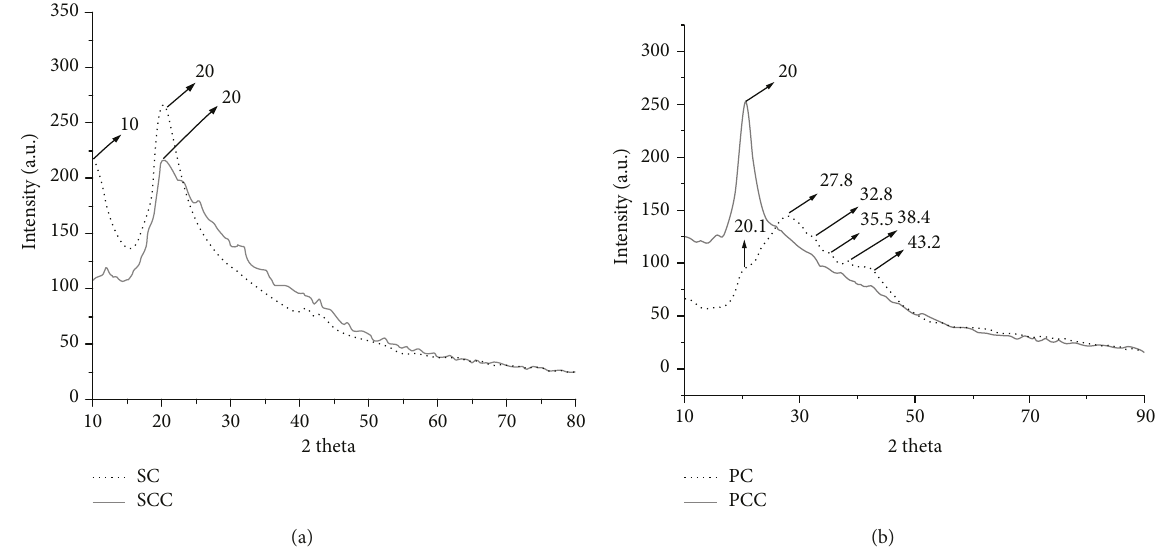
Figure 2: XRD patterns of (a) simple chitosan (SC) and simple chitosan composite (SCC) membranes; (b) porous chitosan (PC) and porous chitosan composite (PCC)